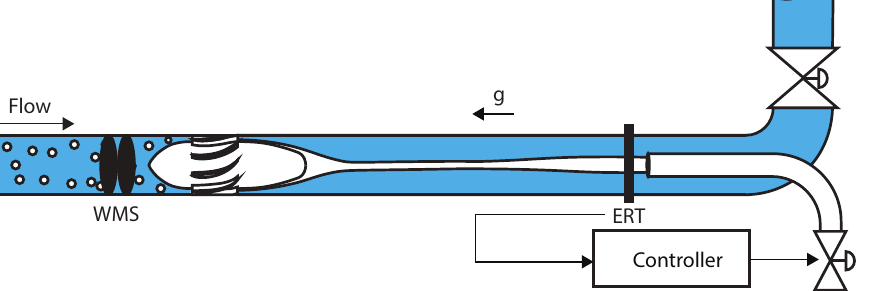
Figure 6. Inline swirl separator with wire-mesh and electrical resistance tomography sensors. The feedback controller of the image connects the gas core size, measured by ERT, to inputs in the pickup tube